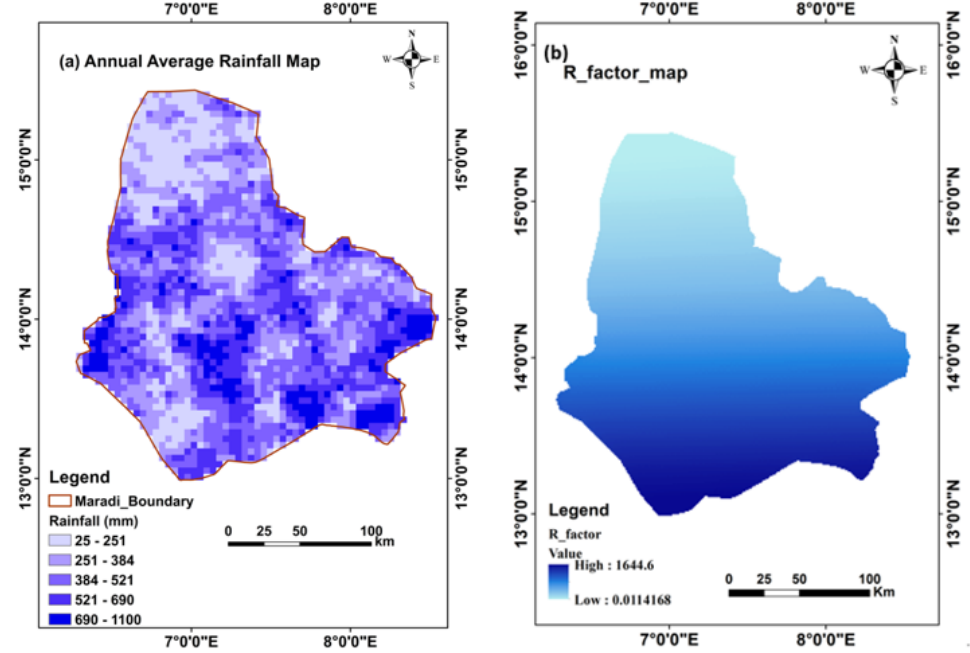
Figure 3. Map of mean annual rainfall ( a ) and distribution of rainfall erosivity (R-factor) ( b ) of the study area.